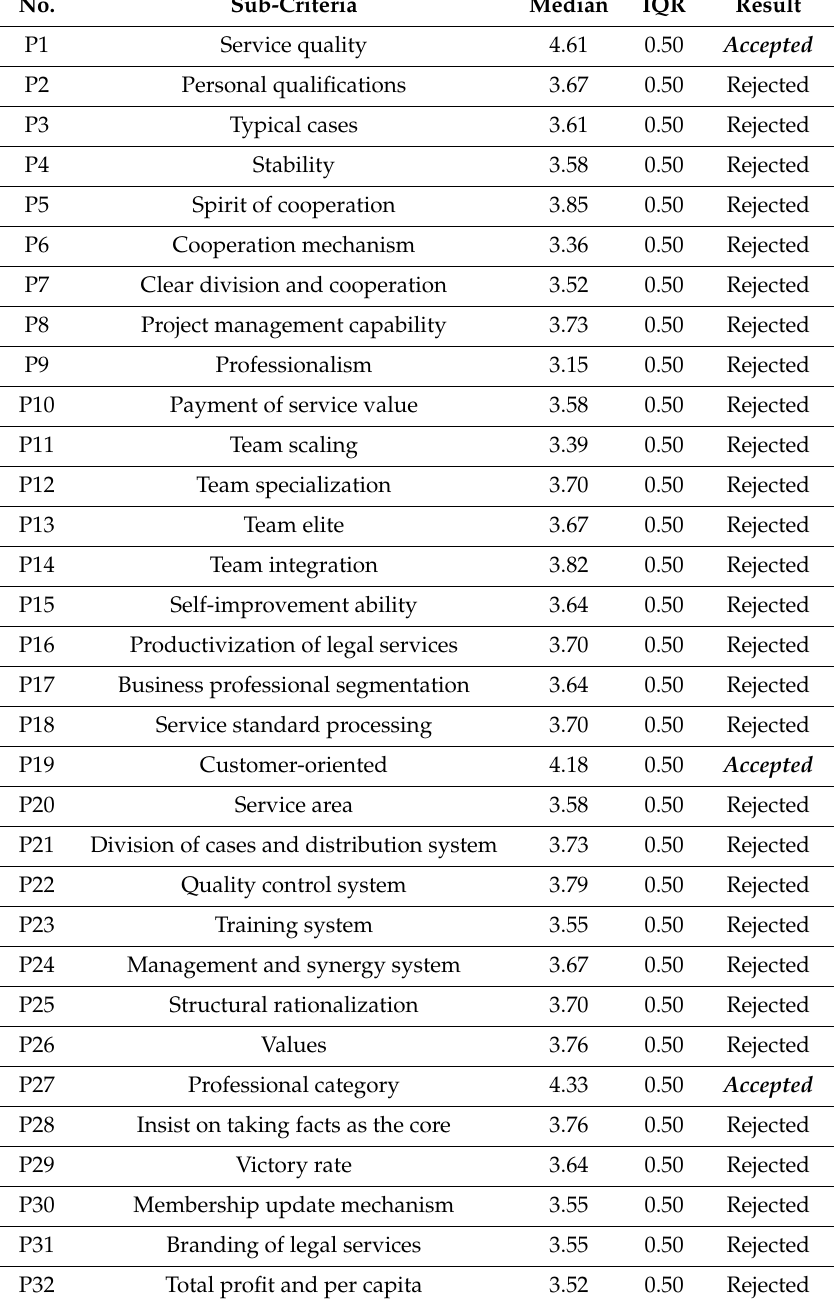
Table 3. Verified results of the professional